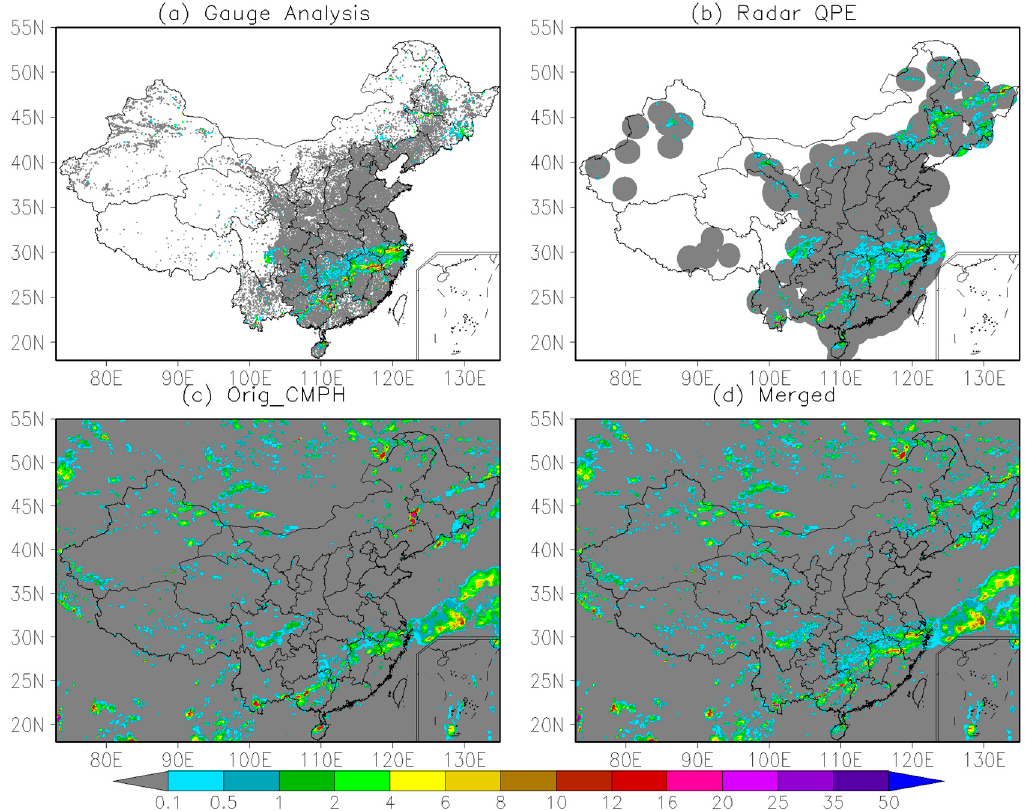
Figure 17. Spatial distribution of the precipitation event occurred at 11Z 8 June 2015 with the resolution of 0.01°depicted by ( a ) gauge-based precipitation analysis (gauge analysis), ( b ) radar QPE, ( c ) Original CMORPH product (Orig_CMPH) and ( d ) the gauge-radar-satellite merged precipitation product (merged) (unit: mm/h).